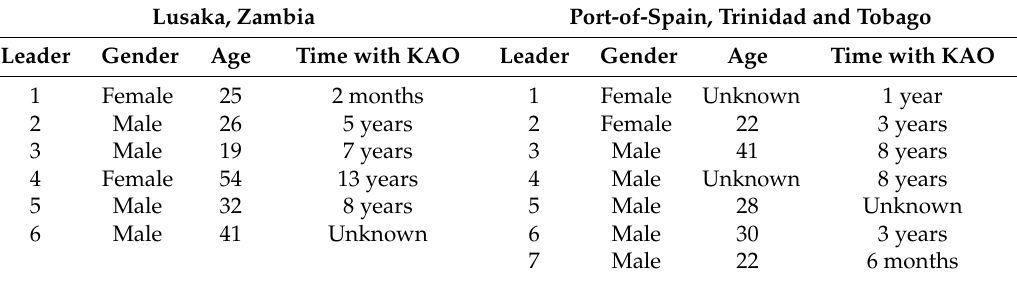
Table 1. KAO leader